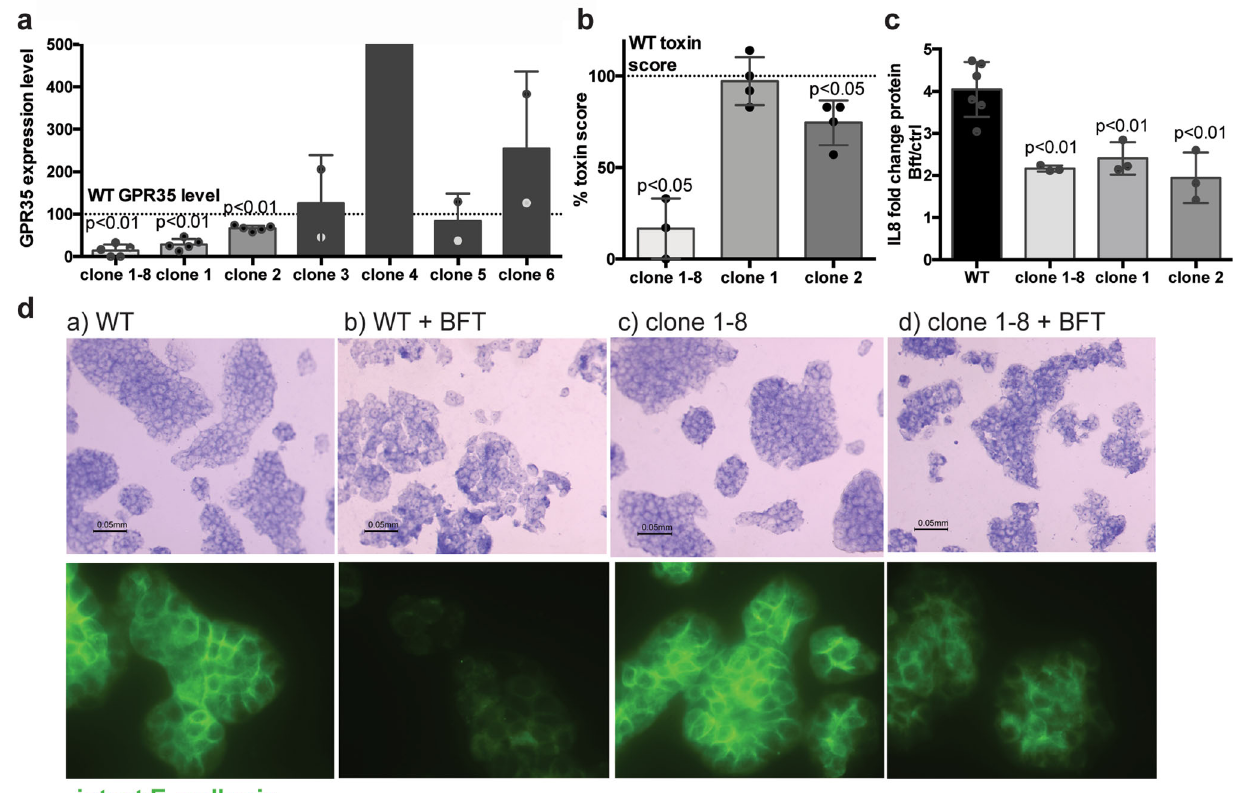
Fig. 1 Clone 1 – 8 GPR35 KD by shRNA results in reduced morphology change, E-cadherin cleavage, and IL-8 secretion. a GPR35 mRNA expression levels relative to GAPDH. GPR35 expression is signi fi cantly reduced compared to wild-type (WT) HT29/c1 cells ( N = 8) in the GPR35 shRNA clones 1 – 8 ( N = 5, P < 0.01), 1 ( N = 5, P < 0.01), and 2 ( N = 5, P < 0.01), but not in clones 3, 4, 5, and 6 ( N = 2 each, one-sample T test). Dashed line represents WT GPR35 level. Two points of clone 4 (540 and 947%) outside the y axis. b Morphology changes of HT29/c1 cells were reduced by clone 1 – 8 ( N = 3, P < 0.05), and clone 2 ( N = 4, P < 0.05), but not clone 1. Dashed line represents WT toxin score (100%). c IL-8 secretion was signi fi cantly reduced in all three GPR35 shRNA clones (clone 1 – 8, clone 1, and clone 2) ( N = 3, P < 0.01) compared to HT29/c1 WT cells ( N = 6). d Representative pictures of morphology (top panels) and intact E-cadherin (green, bottom panels). Untreated HT29/c1 WT and GPR35 shRNA clone 1 – 8 cells are shown in (a) and